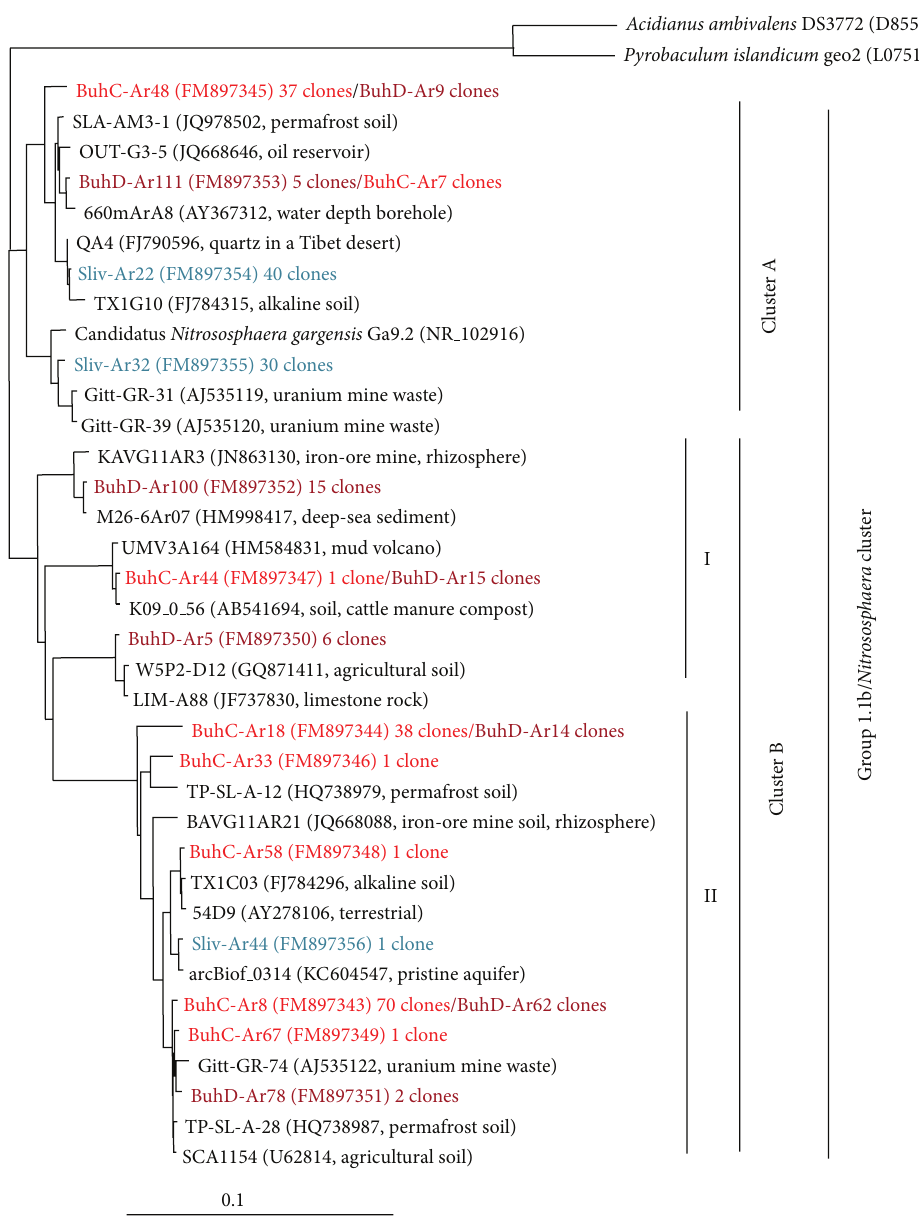
Figure 3: Phylogenetic analysis of archaeal 16S rRNA gene sequences retrieved from uranium mining sites BuhC, BuhD, and Sliv. The tree was constructed using the neighbour-joining method. The 16S rRNA sequences of Acidianus ambivalens DS3772 and Pyrobaculum islandicum geo2 were used as an outgroup. The scale bar represents 0.1 changes per nucleotide